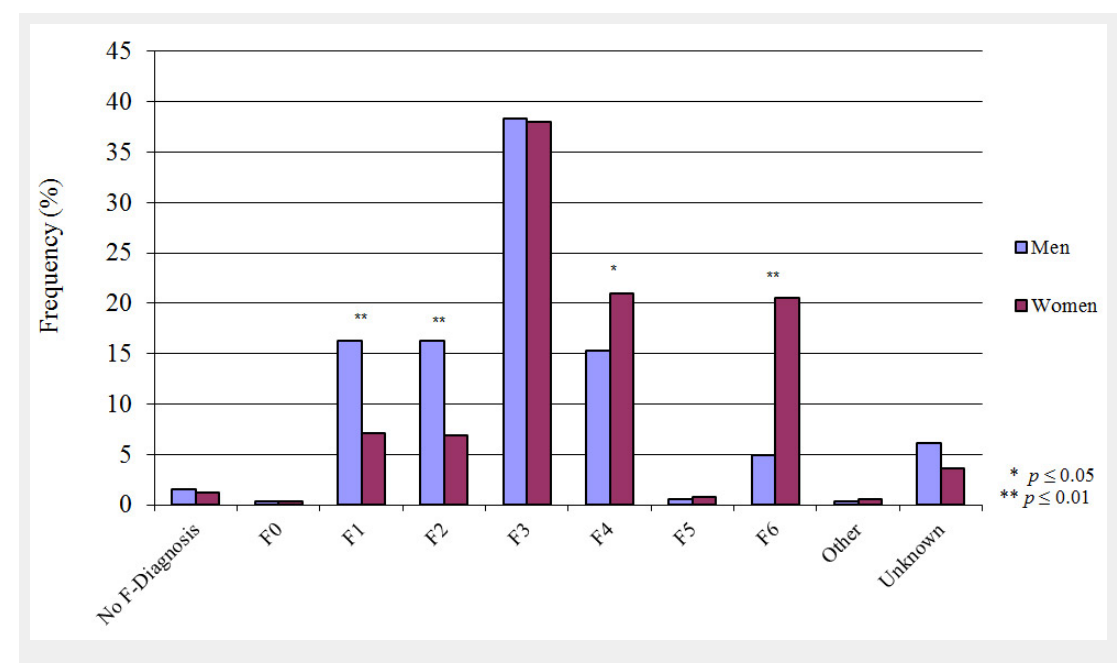
Figure 3 Distribution of primary ICD-10